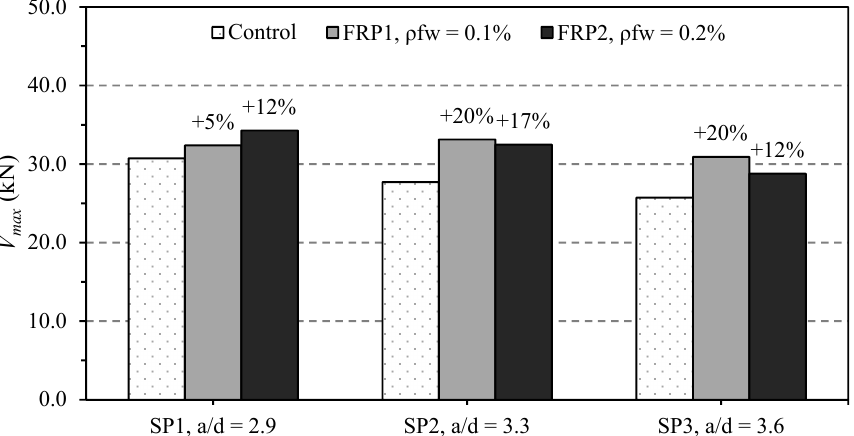
Figure 17. FE analysis on the effect of shear span on the shear strength of FRP-strengthened beams (difference to control specimen in %).